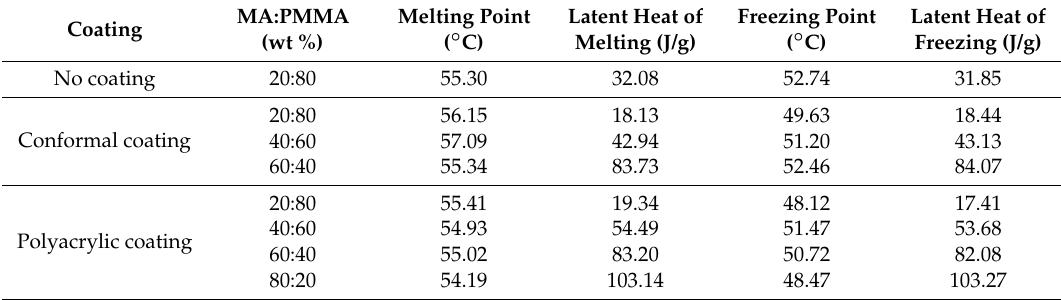
Figure 5. Differential scanning calorimetry (DSC) curves of various samples: ( a ) cooling curves and ( b ) heating curves. Table 2. Thermal properties of various form-stable PCMs.